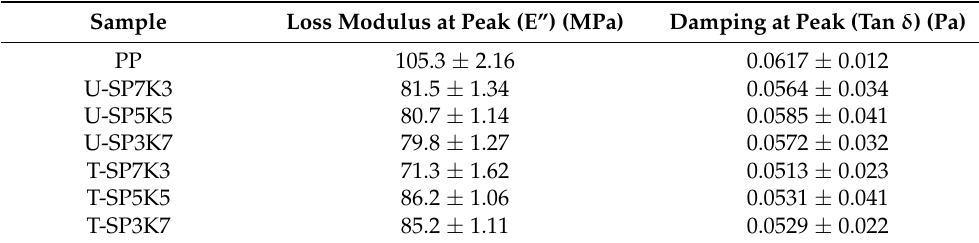
Table 4. Hybrid composite sample (SP/K/PP) with storage modulus (MPa). Sample with Storage Modulus (MPa) Table 5. Loss modulus at peak (E”) (MPa) and damping at peak (Tan δ